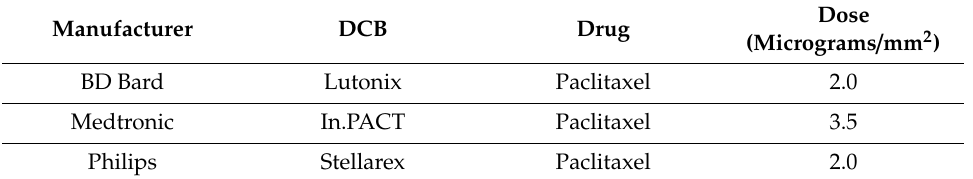
Table 1. Food and Drug Administration (FDA) Approved Drug Coated Balloons.